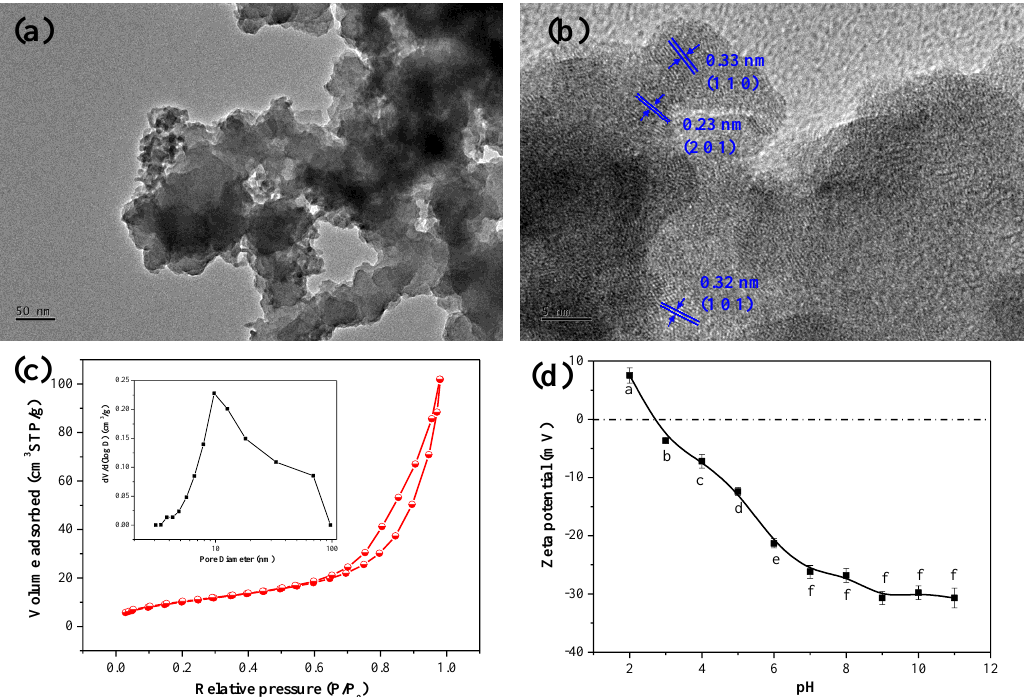
Figure 2. SEM micrographs and EDS analyses of core – shell structured MnO 2 @La(OH) 3 nanocompo- site before ( a ) and after the uptake of As(V) ( b ) and As(III) ( c ).